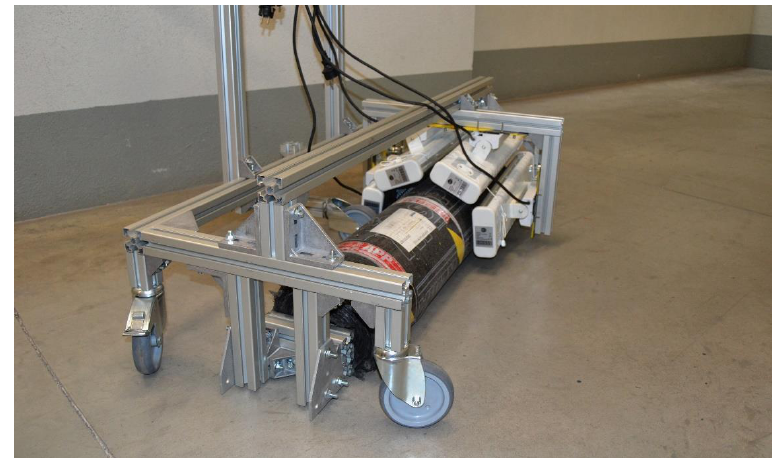
Figure 10. Four infrared heaters surrounding 65% of the roll.